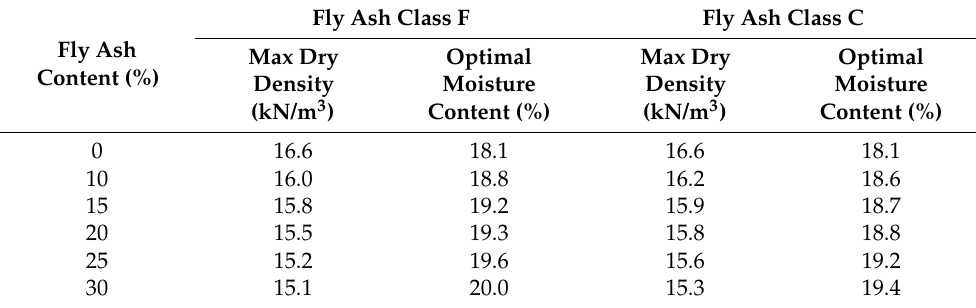
Figure 5. Compaction curves for the specimen stabilized with fly ash class F. Table 3. Optimal moisture contents and max dry densities of the compounds that include a 0–30% fly ash content.